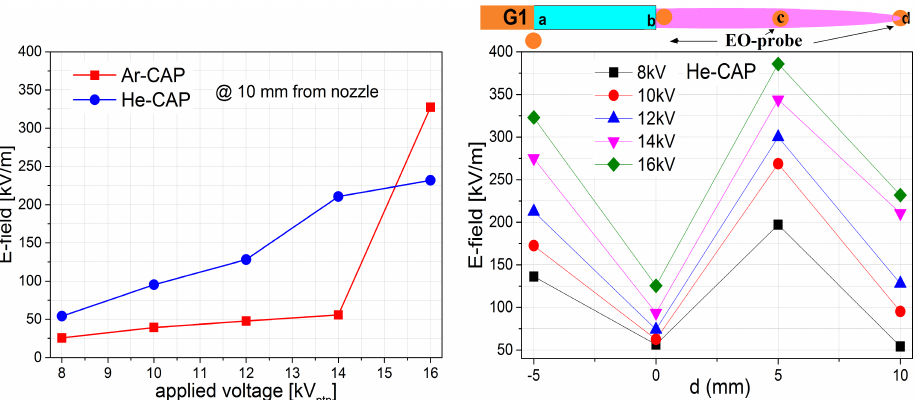
Figure 4. Electrical field strength as function of applied voltage for Ar-CAP and He-CAP ( left ) and for He-CAP as function of distance from the G1 electrode to 10 mm in front of the exit nozzle ( right ). The EO-probe was moved axially to the CAP tube and measurements were made at the nozzle exit (‘b’ = 0 mm), at 5 mm away from nozzle (‘c’), at 10 mm away from nozzle (‘d’) and near the ground electrode, on the tube at − 5 mm from the nozzle exit (positioned instead of the letter ‘a’), exactly as in the right figure (orange circles =